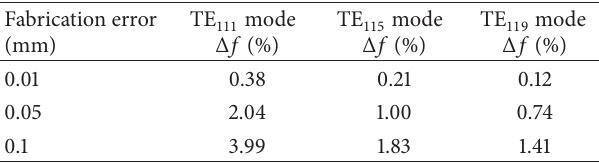
Table 7: Simulated frequency shift of higher order modes of a rectangular DRA due to fabrication tolerances [62].